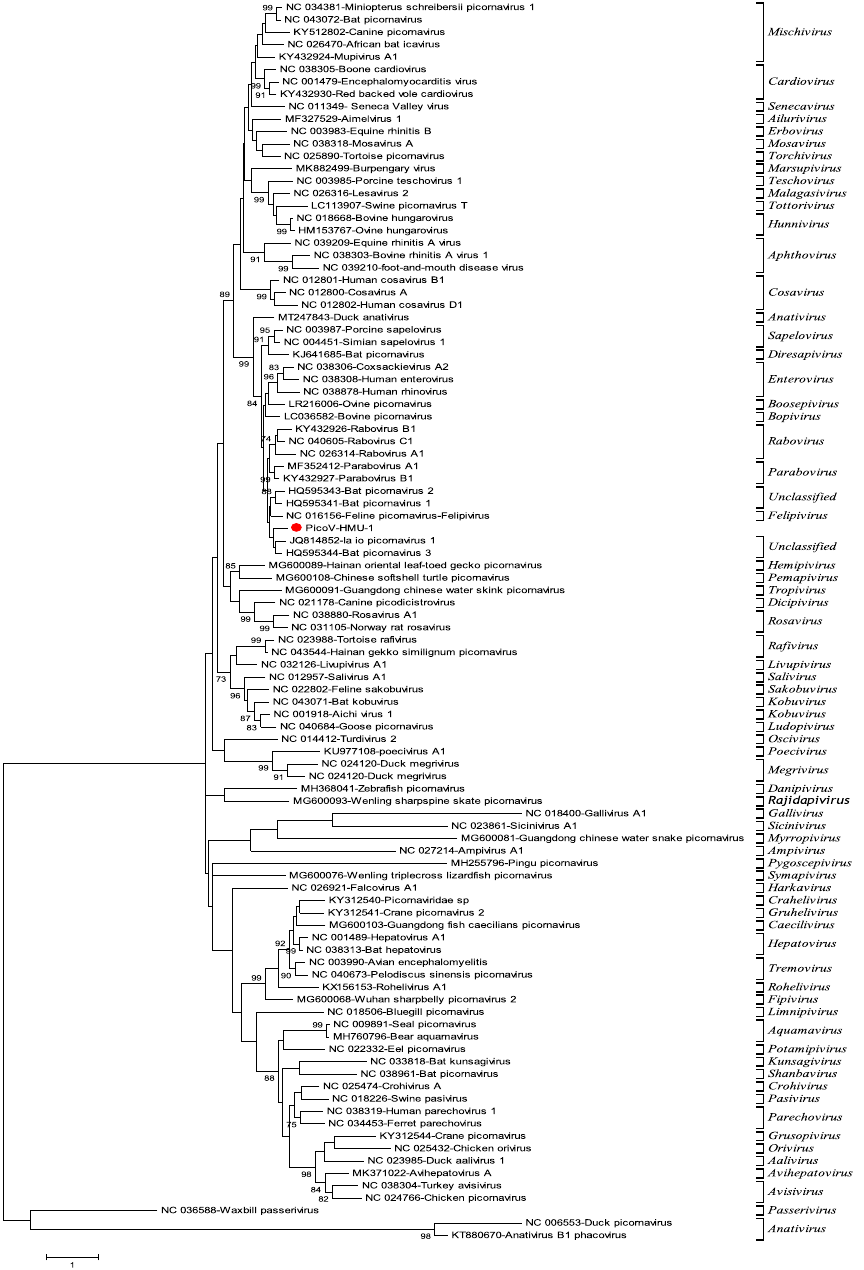
Figure 4. Phylogenetic analyses of the P1 regions of PicoV-HMU-1. Maximum likelihood mtREV with the Freqs (+ F) model, gamma distributed with invariant sites (G + I), and 1000 bootstrap replicates using MEGA 6 software. The virus identified in this study is indicated by the red circle. Bootstrap values are shown on the